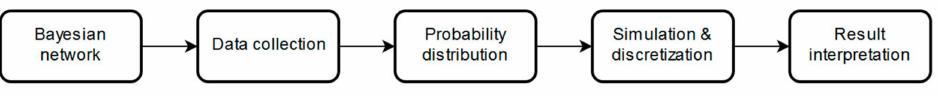
Figure 2. Essential methodology steps in Bayesian network